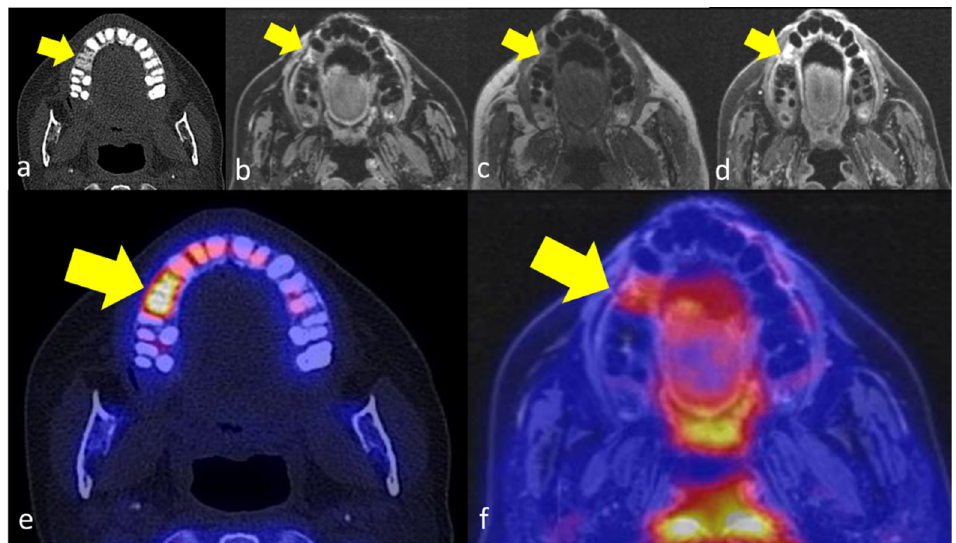
Figure 3. 49 yr. old female patient with secondary chronic OMJ in region 15 of the maxilla (yellow arrows). The OM affected jawbone shows a diffuse trabecular sclerosis in CT ( a ), an edema in T2-weighted images ( b ) and corresponding T1-weighted images ( c ) with increased contrast enhance- ment after gadolinium application ( d ). The corresponding PET images show a markedly increased [18F]fluoride uptake in the affected jawbone ( e ) and an increased [18F]FDG-uptake ( f